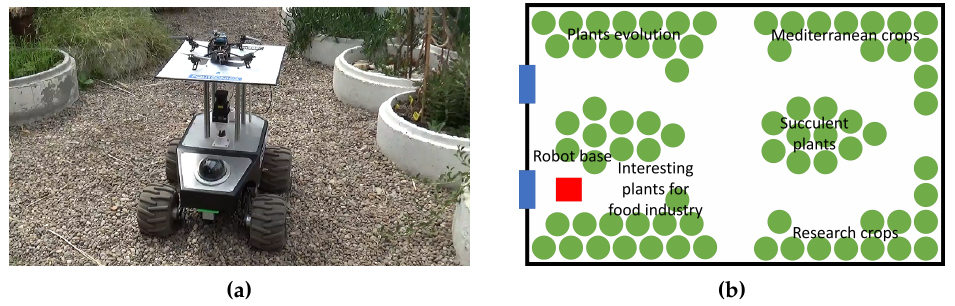
Figure 11. Experiments: ( a ) robot team; ( b ) greenhouse layout.